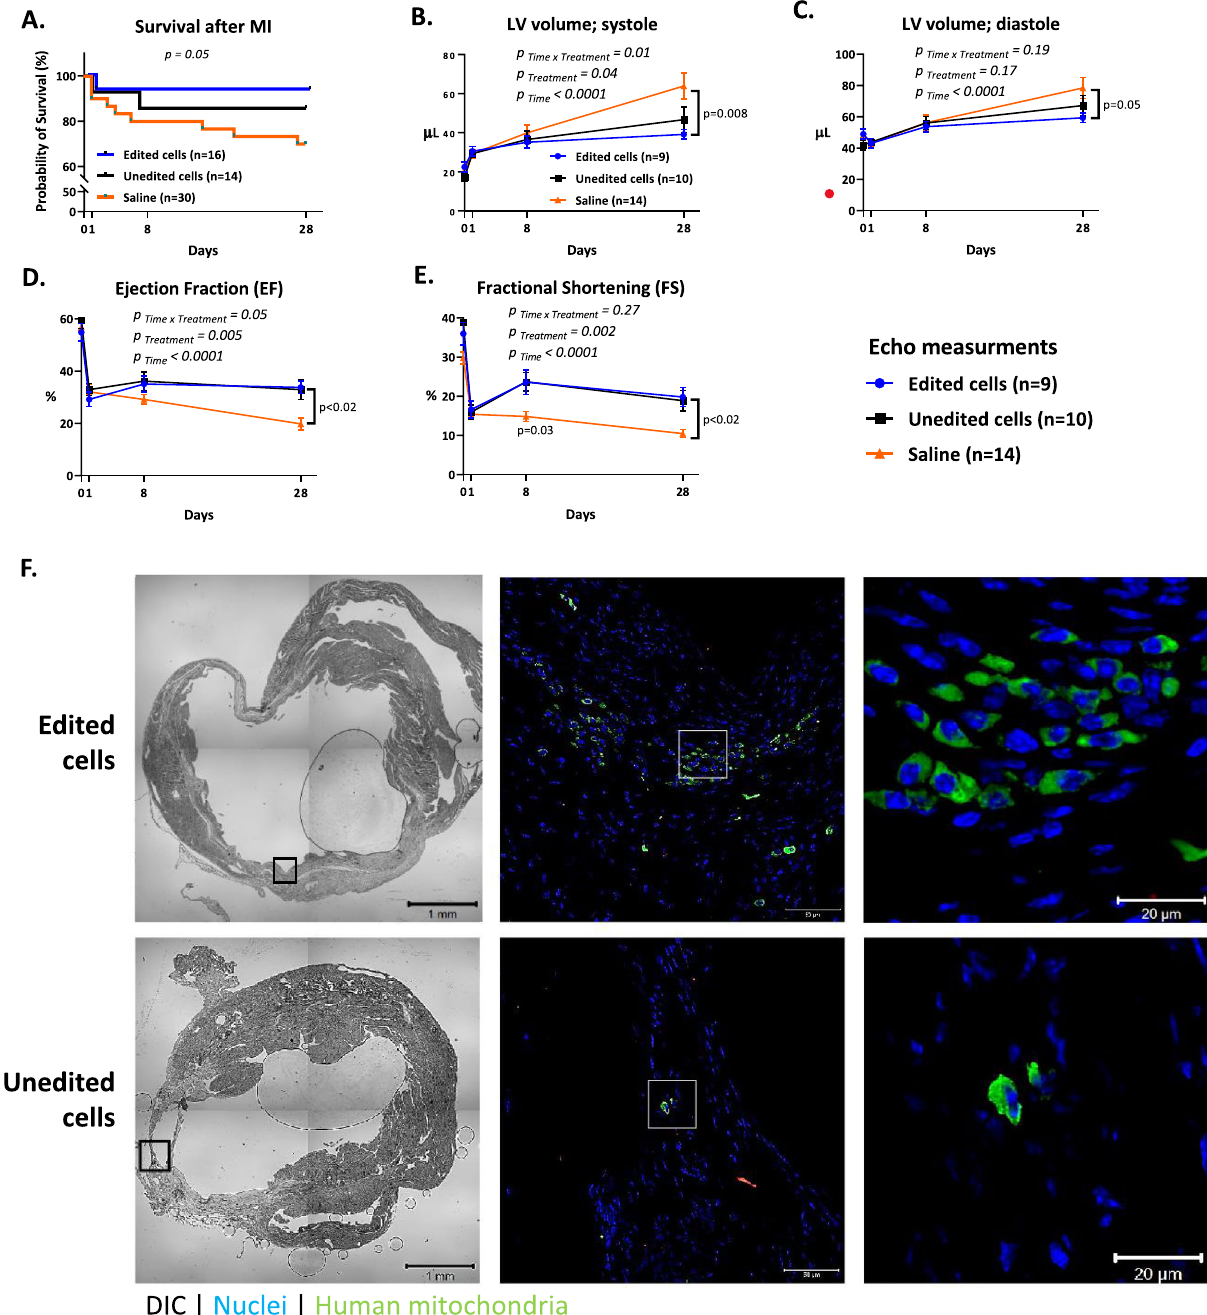
Figure 5. Cell Therapy after MI Improved Survival and Prevented LV Dilatation. To determine the reparative effects of edited and unedited cells on the infarcted heart, we allocated 48 12-week-old Balb/C female mice to MI and a single intra-myocardial injection of edited, unedited cells, or saline. LV remodeling and function were assessed by echocardiography before (baseline), 1, 8, and 28 days after MI. On day 28 post-MI, hearts were harvested for further analyses. ( A ) Survival curve for three treatment groups, 28 days post-MI. Log-rank test for trend analysis demonstrates that mice treated with edited cells had the best survival rate compared with other groups with MI. ( B , C ) Serial measurements of systolic and diastolic LV volumes revealed that both edited and unedited cells reduced LV dilatation 28 days after MI, compared with the saline-treated group. This favorable effect was statistically significant for the edited cells. ( D , E ) LV contractility, as indicated by EF and FS, was improved by both edited and unedited cells. This favorable effect was statistically significant for the edited cells. Statistical analyses were performed by repeated-measures two-way ANOVA with Holm-Šídák’s multiple comparisons test. ( F ) To visualize cell engraftment after injection into the infarct, slides were stained with a human mitochondria marker 28 days post-MI. Images acquired with a confocal microscope show batches of human cells adjacent to the viable myocardial islands within the scar in mice treated with edited cells. On the contrary, only sporadic cells were found in mice treated with unedited cells. Abbreviations MI, myocardial infarction; LV, left ventricular; DIC, differential interference contrast; echo, echocardiography; EF, ejection fraction; FS, fractional shortening; hMSCs, human mesenchymal stromal